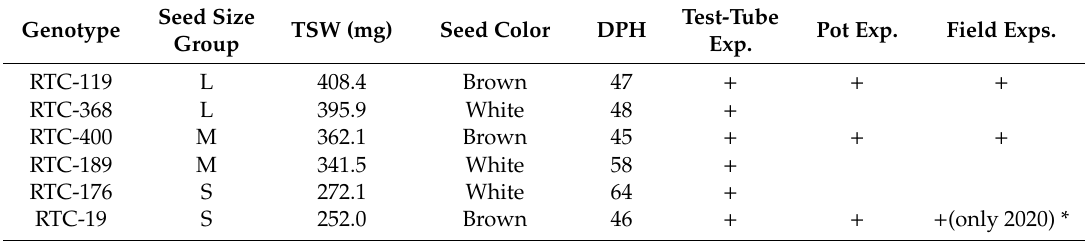
Table 1. Characteristics of genotypes used in this study.